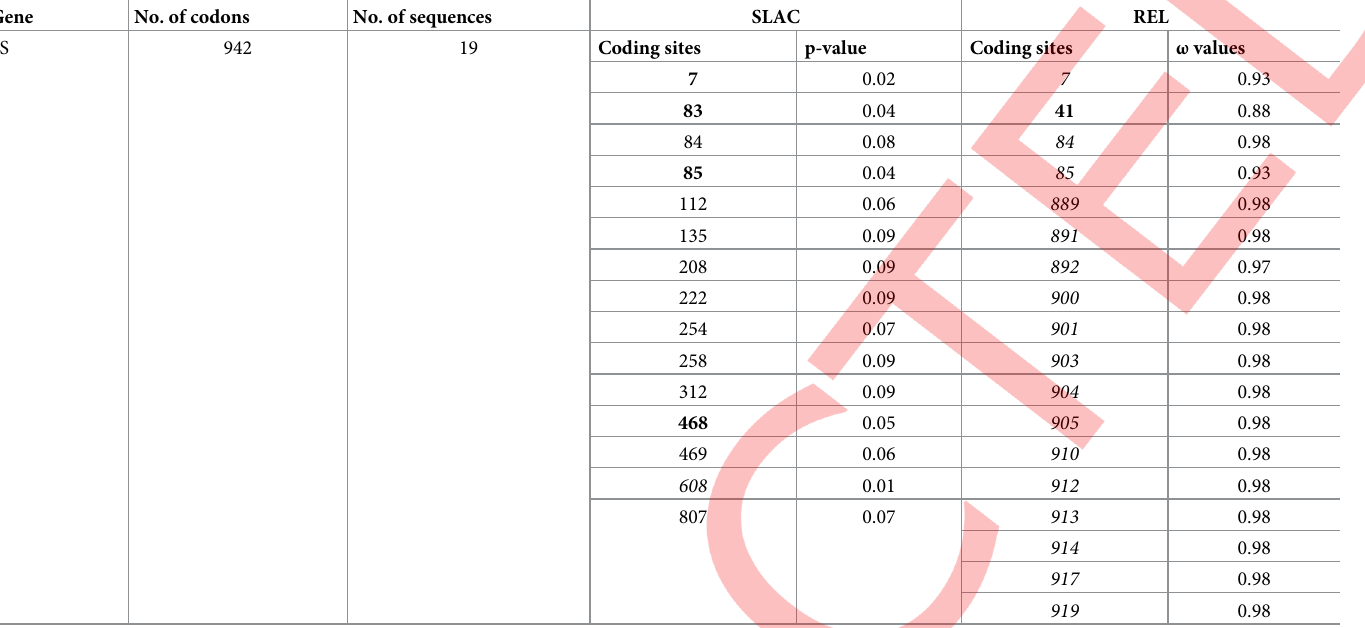
Table 4. Log likelihood values of positively selected coding sites in SS family genes through different models.